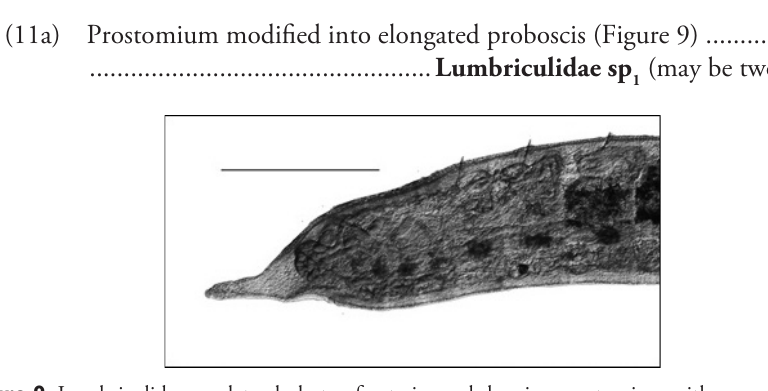
Figure 9. Lumbriculidae sp : lateral photo of anterior end showing prostomium with conspicuous pro- 1 boscis (scale 500 µm).